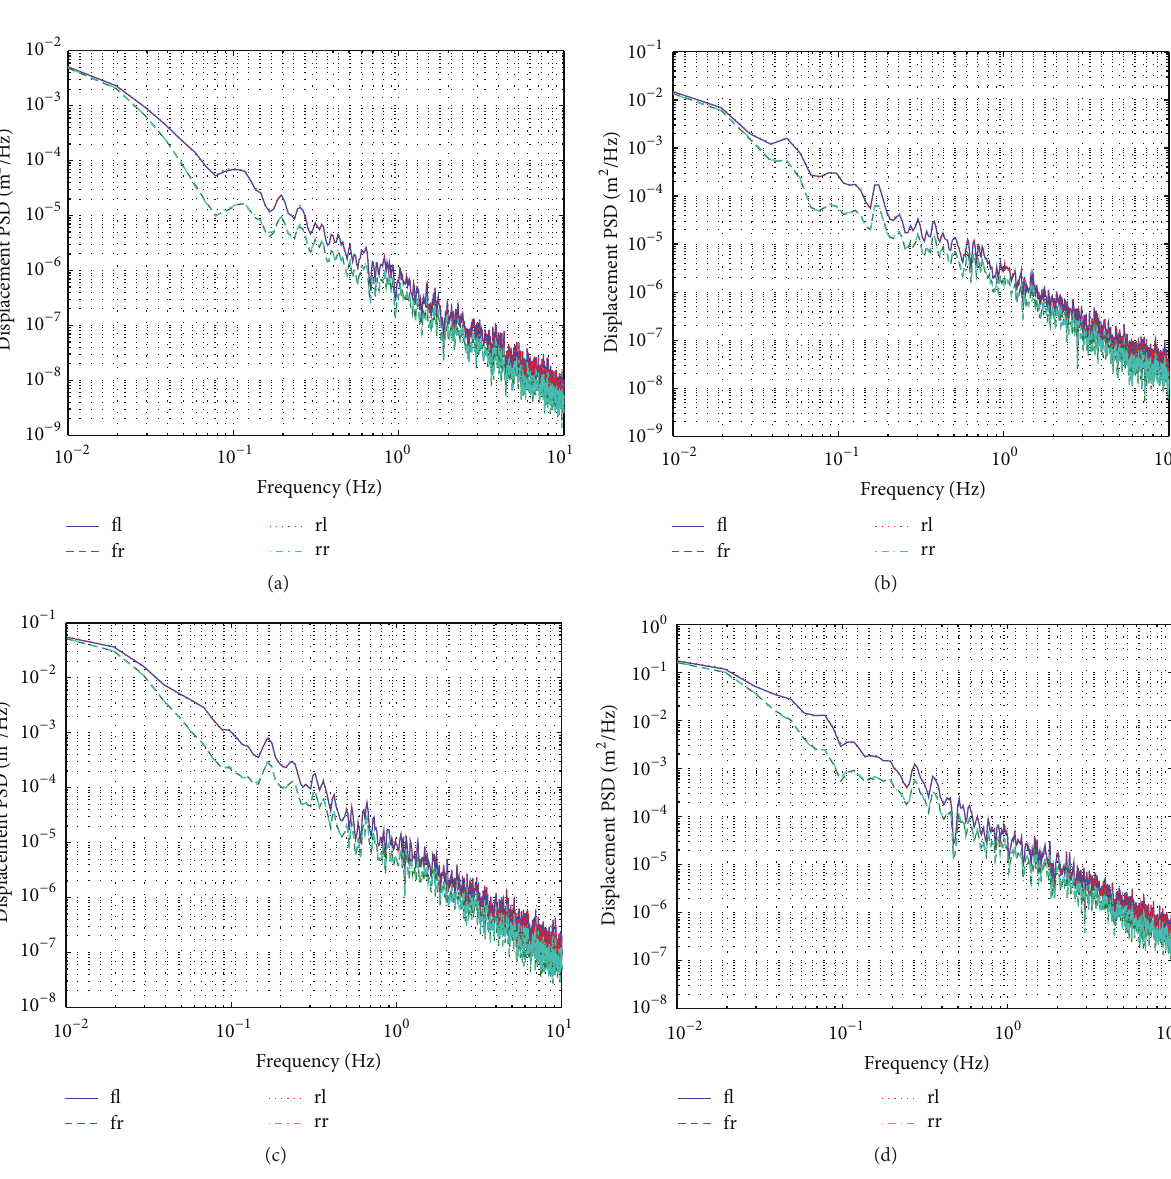
Figure 15: Vertical displacement temporal PSD characteristics of four road profiles at a speed of 90 km/h: (a) Smooth. (b) Medium-smooth. (c) Medium-rough. (d)